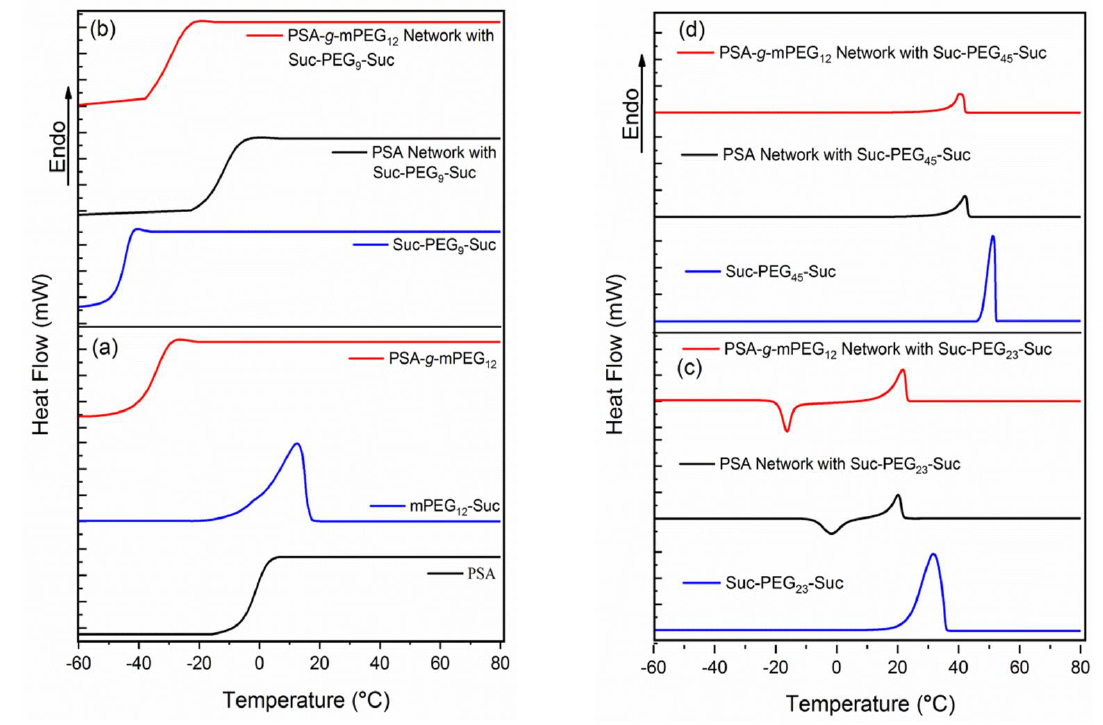
Figure 4. Differential scanning calorimetry ( DSC) heating traces with a heating rate of 1 °C·min −1 . ( a ) Polymers; PSA, mPEG 12 -Suc, and PSA- g -mPEG 12 , ( b ) Suc-PEG 9 -Suc (cross-linker), PSA networks crosslinked with Suc-PEG 9 -Suc, and PSA- g -mPEG 12 based networks cross-linked with Suc-PEG 9 -Suc, ( c ) Suc-PEG 23 -Suc (cross-linker), PSA networks cross-linked with Suc-PEG 23 -Suc, and PSA- g -mPEG 12 based networks cross-linked with Suc-PEG 23 -Suc, ( d ) Suc-PEG 45 -Suc (cross-linker), PSA networks cross-linked with Suc-PEG 45 -Suc, and PSA- g -mPEG 12 based networks cross-linked with Suc-PEG 45 -Suc. Table 1. Number average molar mass ( M n ), dispersity ( Ð ), glass transition temperature ( T g ), melting temperature ( T m ), and melting enthalpy ( ∆ H m ) of polymer precursors and networks. Polymers and